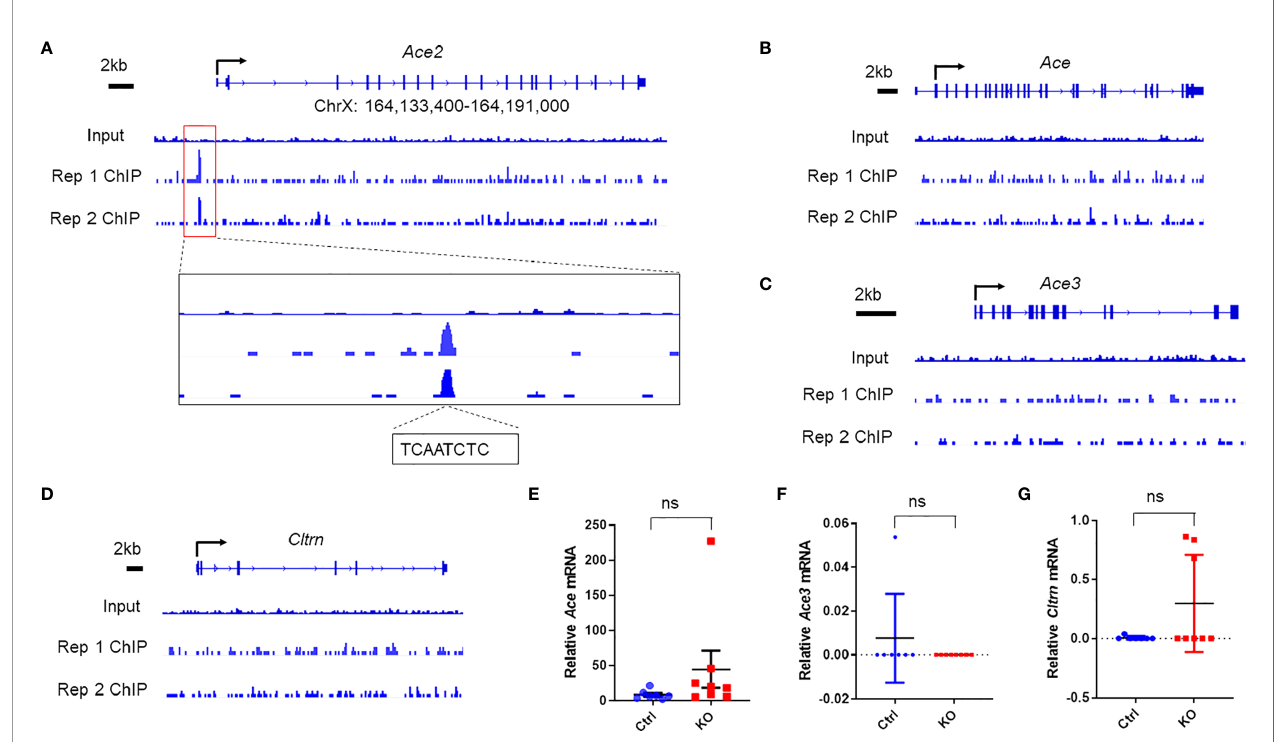
FIGURE 1 | Miz1 speci fi cally binds to the Ace2 promoter in mouse lung epithelial cells as analyzed by ChIP-seq. ChIP-seq traces of Miz1 on the promoters of Ace2 (A) , Ace (B) , Ace3 (C) , or Cltrn (D) as indicated. Input is shown as control. Two biological replicates are shown, which represent two independent experiments. In (A) , Miz1 binding peak on the Ace2 promoter is enlarged for viewing and Miz1 binding sequences on the Ace2 promoter are indicated as “ TCAATCTC ” . (E – G) mRNA expression of Ace (E) , Ace3 (F) , or Cltrn (G) by RNA-seq in fl ow-sorted primary lung epithelial cells isolated from age-matched control Miz1 fl / fl (n = 7) or SPC-Cre + /Miz1 fl / fl mice (n = 8). Data are presented as means ± sem. ns, not signi fi